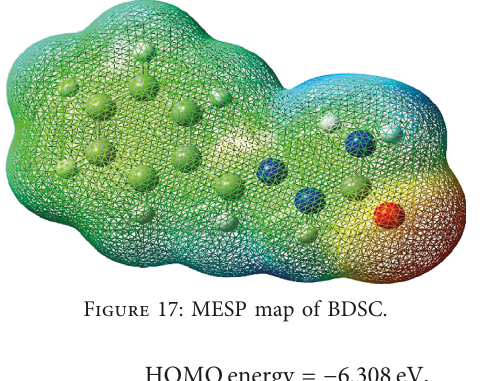
Figure 17: MESP map of